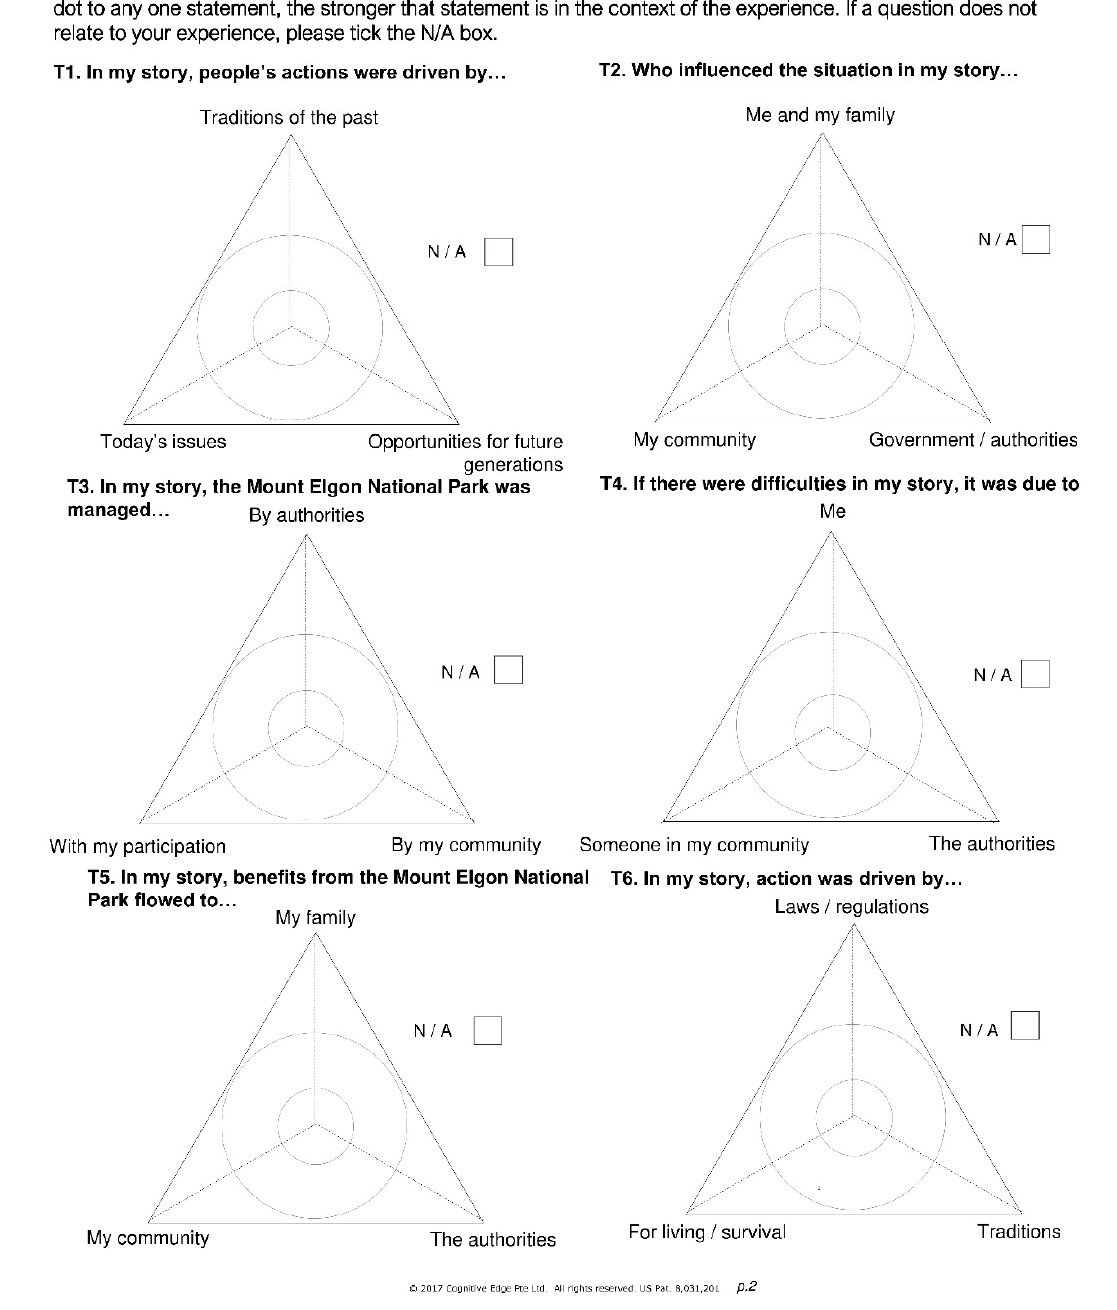
Figure A2. Details about Story Triads